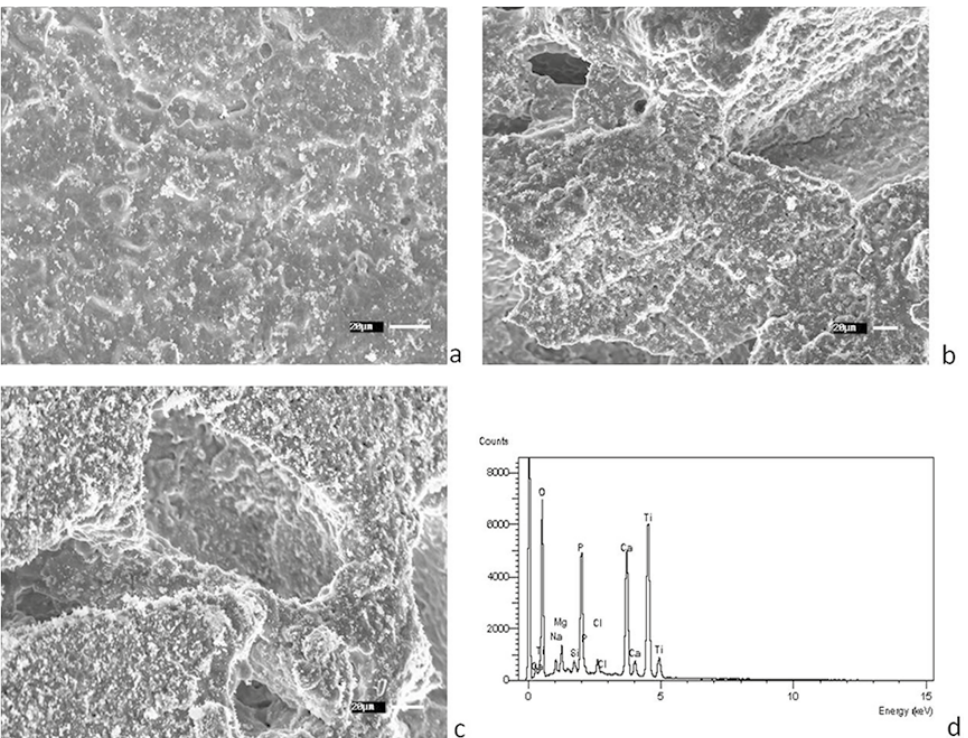
Figure 3. SEM image pure Ti submitted to CaP coating Ca: a) dense sample; b) 30% porous sample; c) 40% porous sample; d) EDS